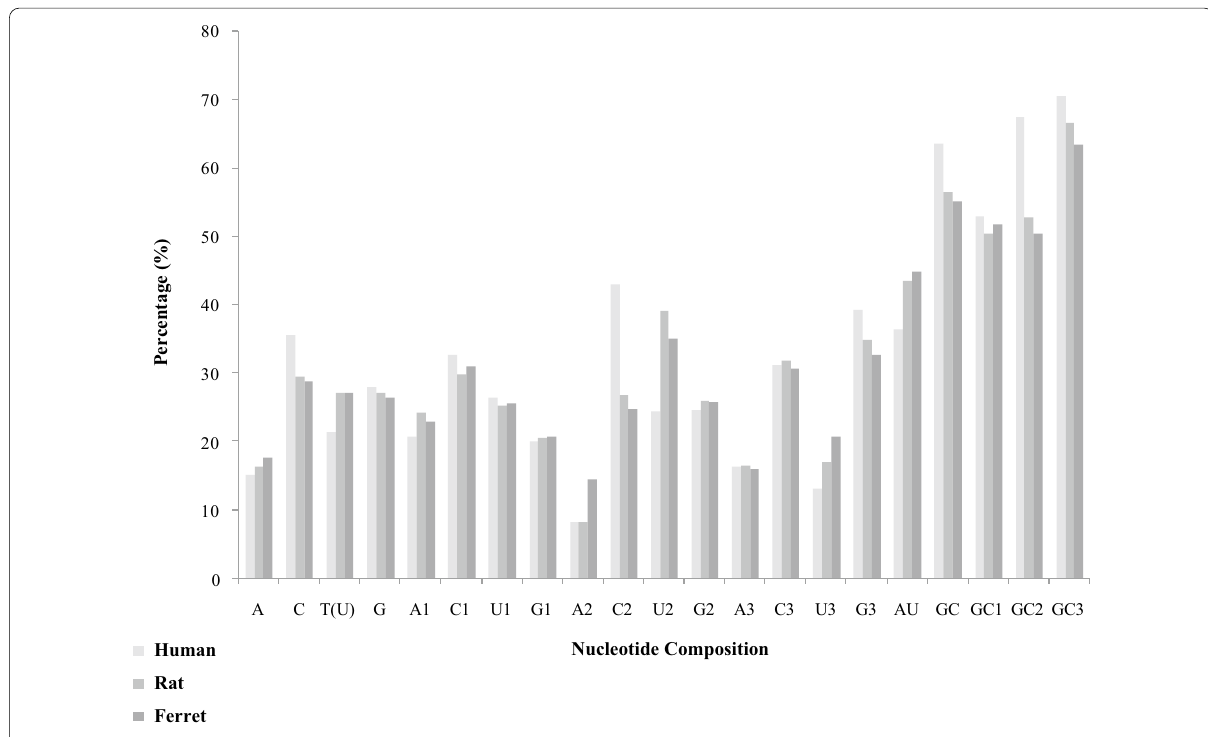
Fig. 1 Comparative analysis of nucleotide composition patterns between HEV host organisms (human, rat and